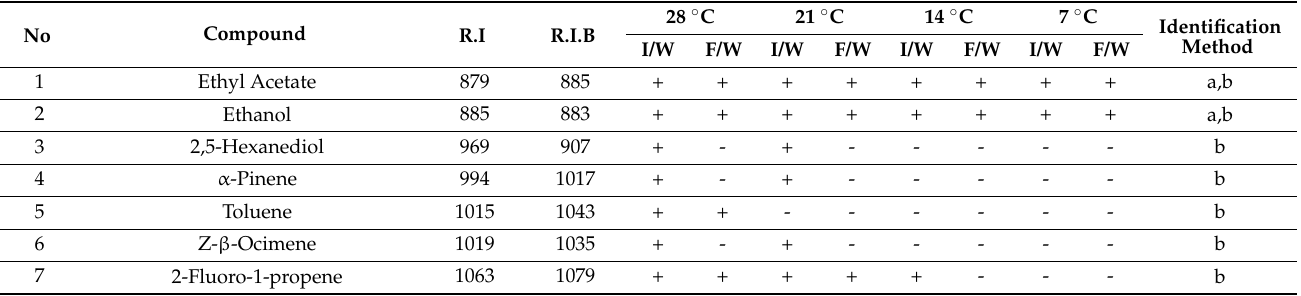
Table 5. Volatile by-products detected by SPME/GC-MS analysis in must fermentation batches (12.5 ◦ Be) using immobilized and free cells at 28, 21, 14 and 7 ◦